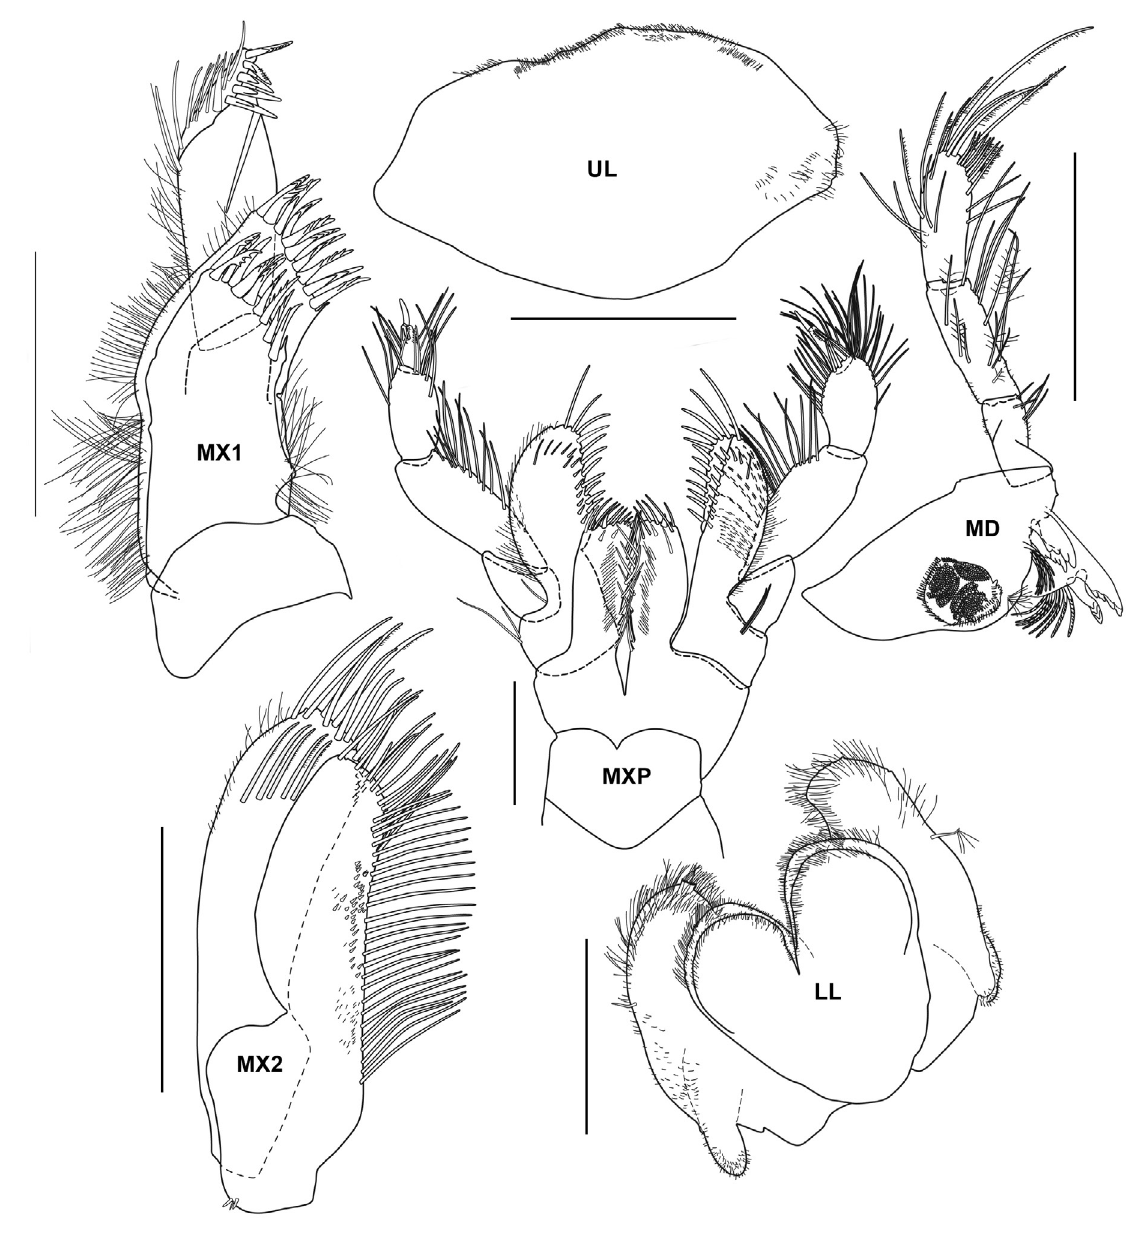
Fig. 17. Grandidierella sungeicina sp. nov., allotype, ♀ (ZRC 2018.0491). Scale bars: MD = 0.5 mm; remaining scales = 0.25